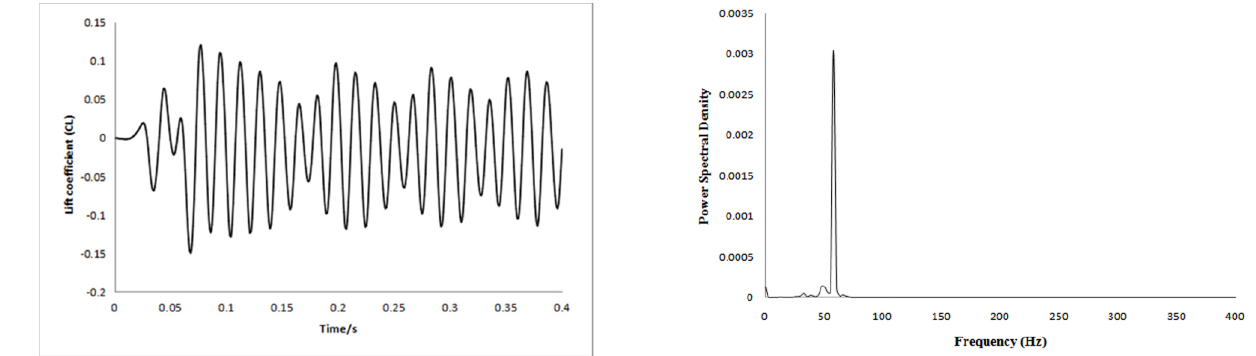
Figure 7. The lift coefficient time history curve and power spectrum curve of the vibration area under the 90% operation mode.